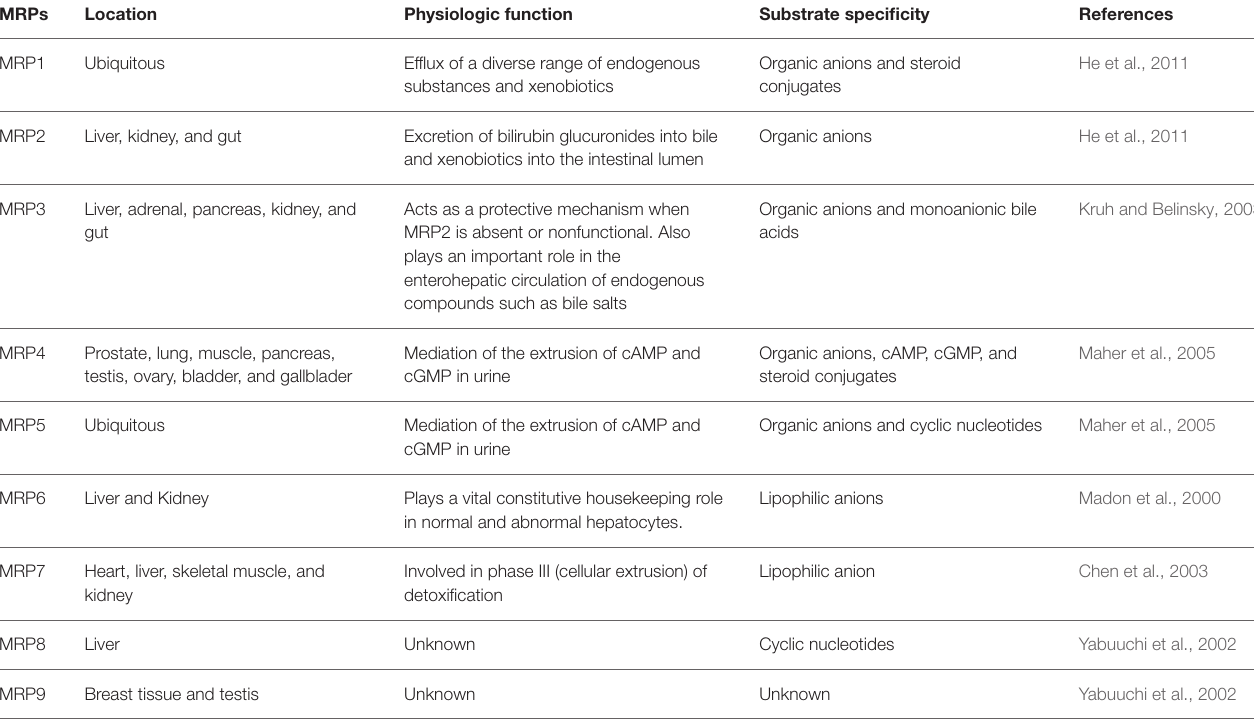
TABLE 1 | Distribution, physiologic function, and substrate specificity of human multidrug resistance